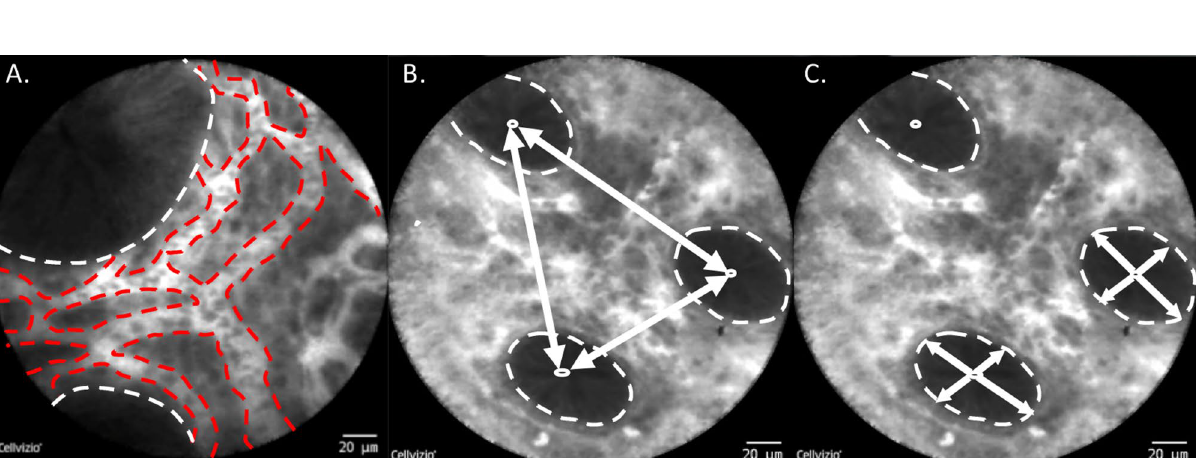
visualizing barrier dysfunction in the colon with pCLE, a sensitivity of 37% and a specificity of 82% for the diagnosis of FA were obtained with a positive and negative prediction of 62.5% and 61%, respectively (Table 3). Cryptometry of the colon with pCLE in patients with and without Food Allergy. lumina diameter) and colonic vascularization are different between patients with and without FA (Fig. 5). As shown in Table 4, intercrypt distance (ICD) was virtually identical in patients with and without FA (mean